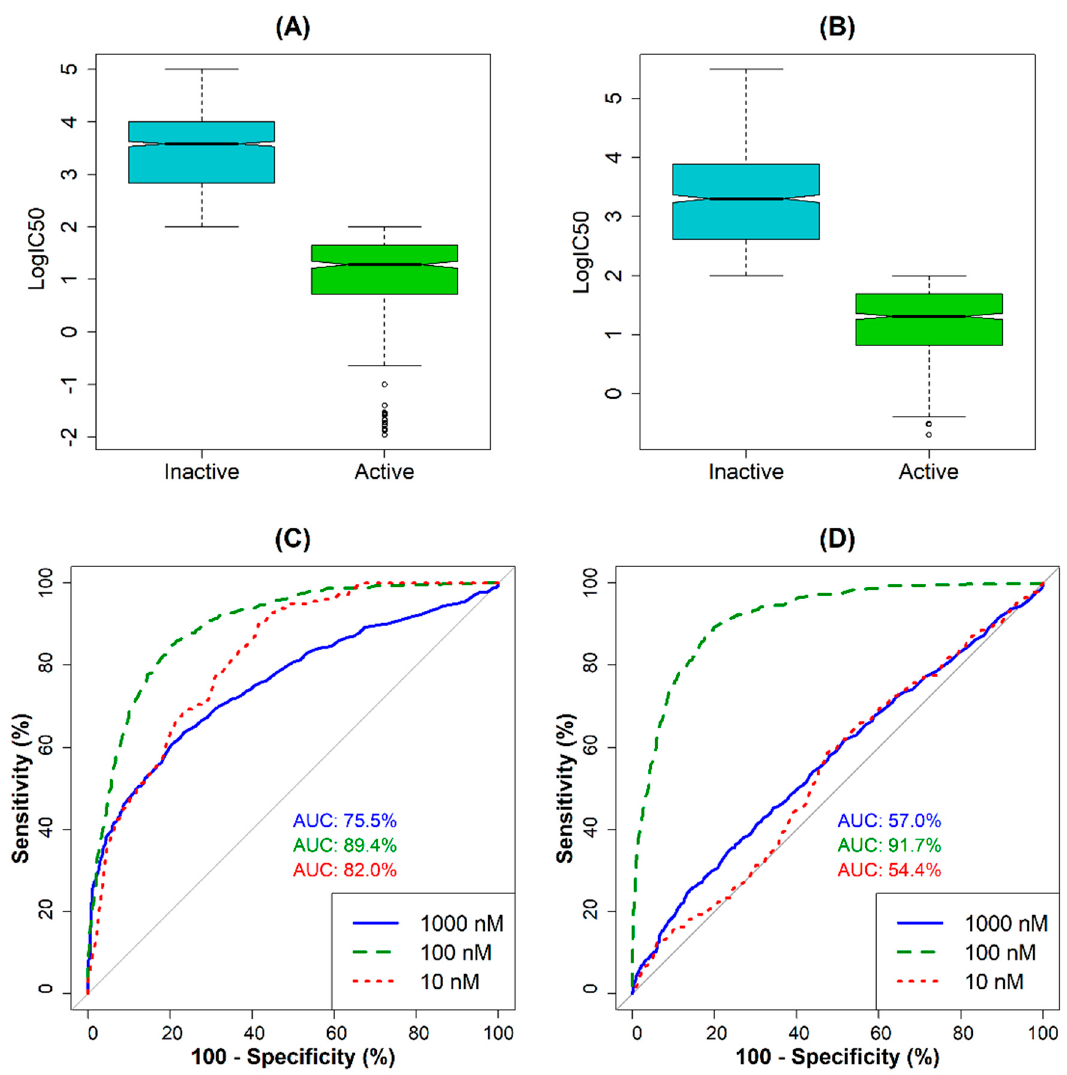
Figure 1. Distribution of the IC 50 values for ( A ) active vs. inactive AChE inhibitors; ( B ) active vs. inactive BACE1 inhibitors; ROC − curve − based selection of cut-off values for ( C ) AChE inhibition and ( D ) BACE1